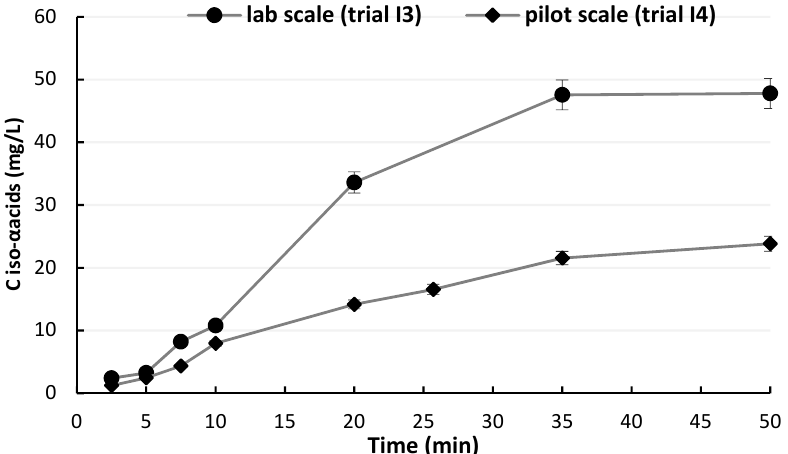
Figure 6. iso- α -acid concentration (c iso- α -acids ) measured during isomerization trials performed at laboratory- (I3) and pilot-scale (I4) using HFC hop extracts.